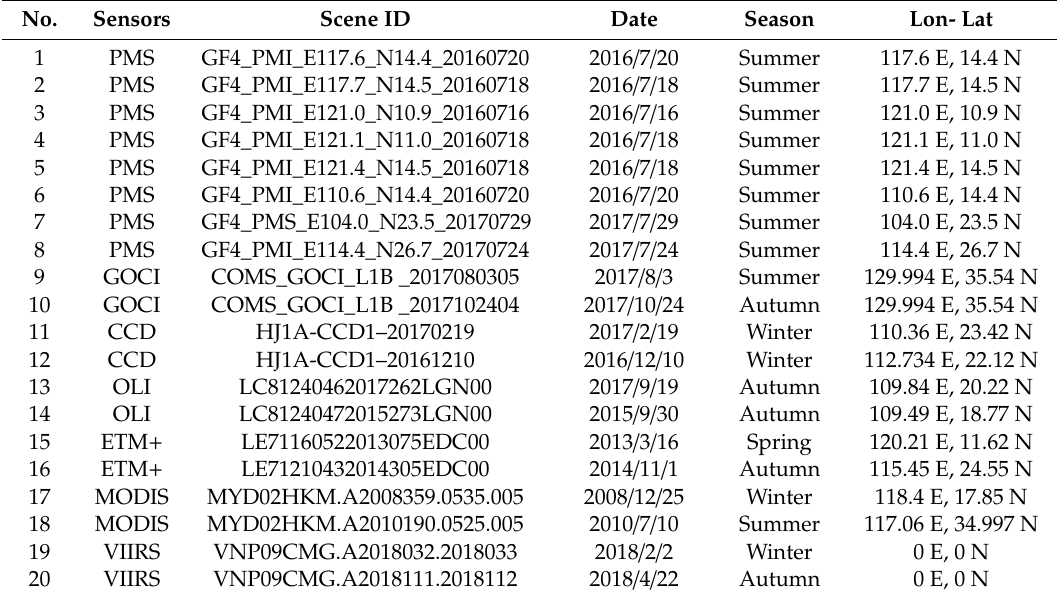
Table 2. Information on the data used in the present